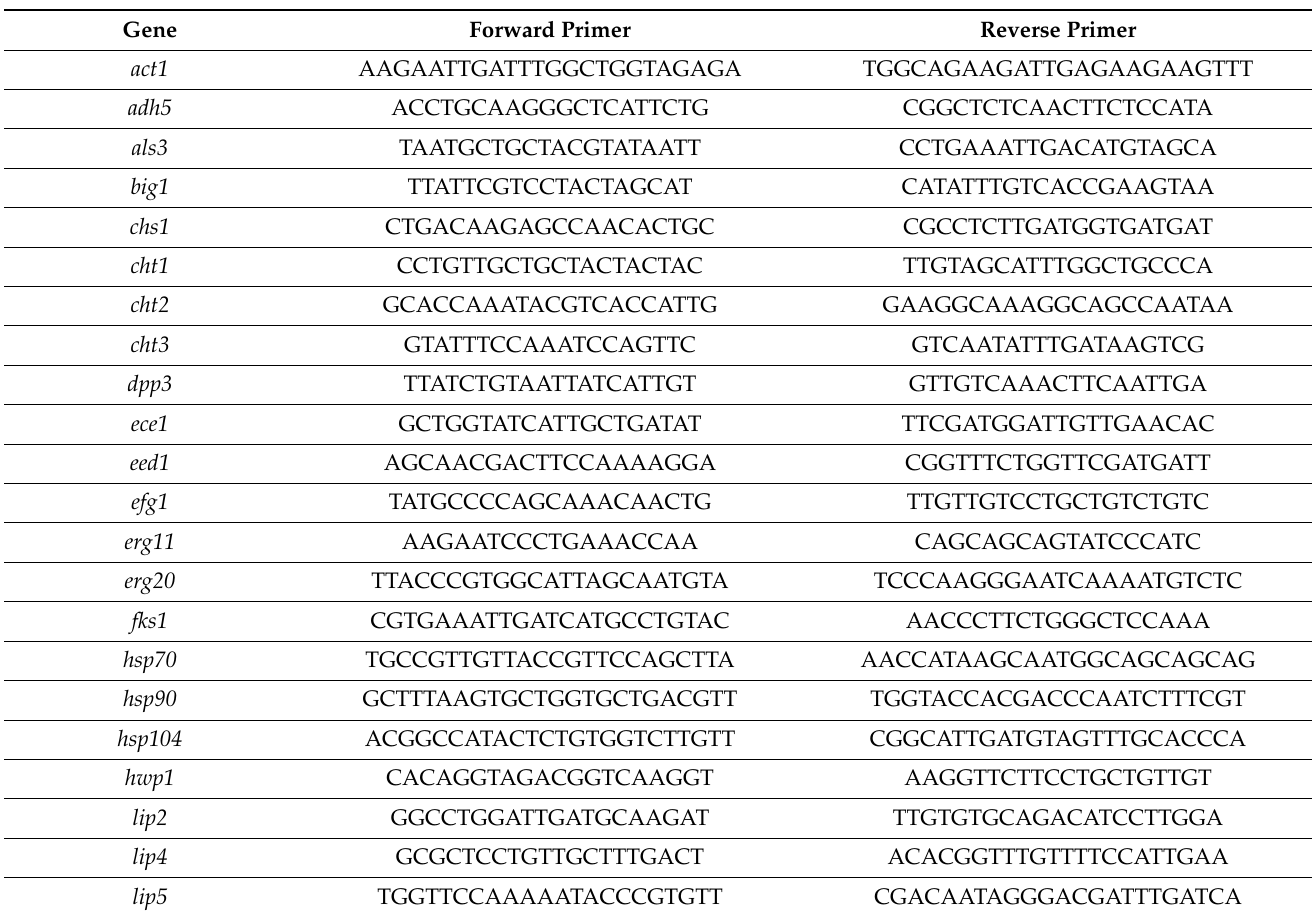
Table 3. Primers used for real-time